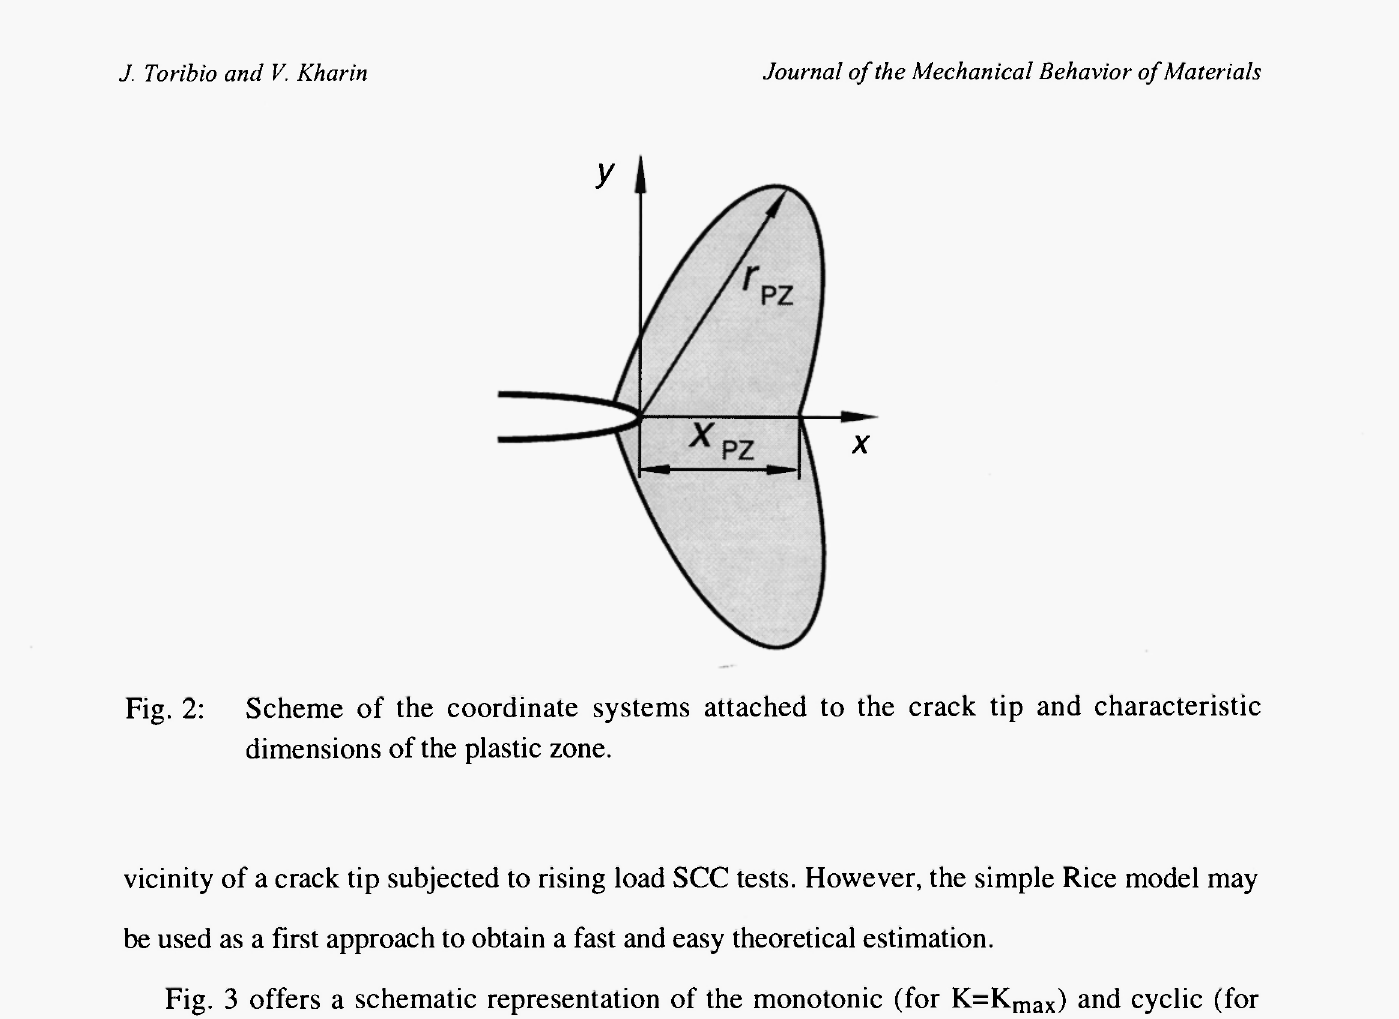
Fig. 2: Scheme of the coordinate systems attached to the crack tip and characteristic dimensions of the plastic